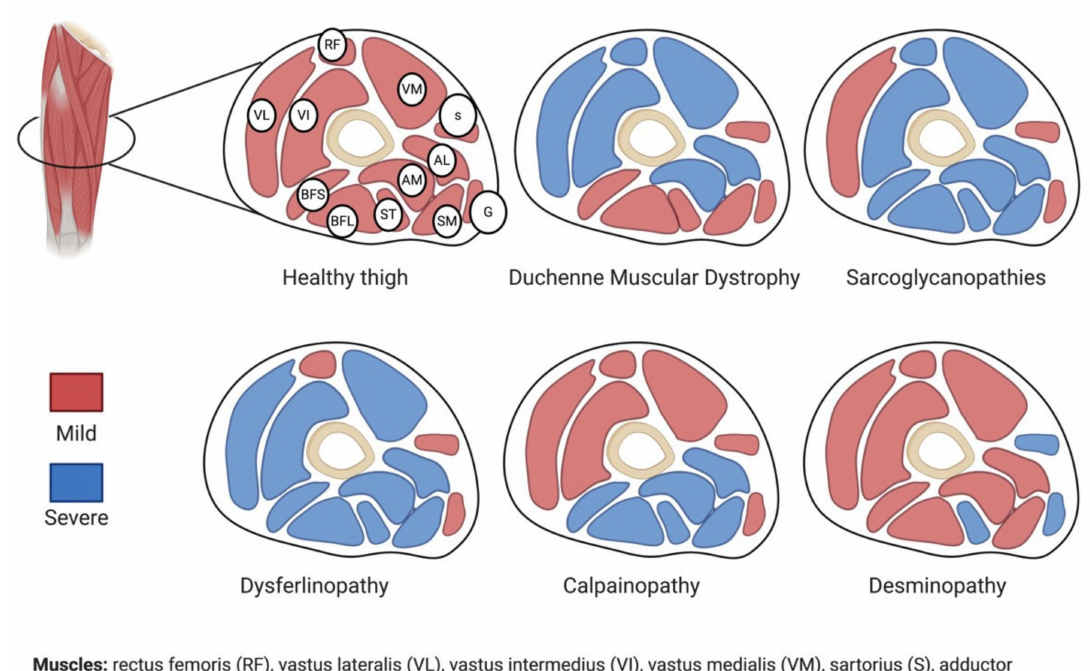
Figure 1. Schematic presentation of thigh human transversal sections: level of damage severity of the muscle groups in different muscular dystrophies. MRI-based representation of human thigh (middle) transversal sections. Red color: mild muscle pathology or late disease stage; blue color: severe muscle pathology or early stage of the